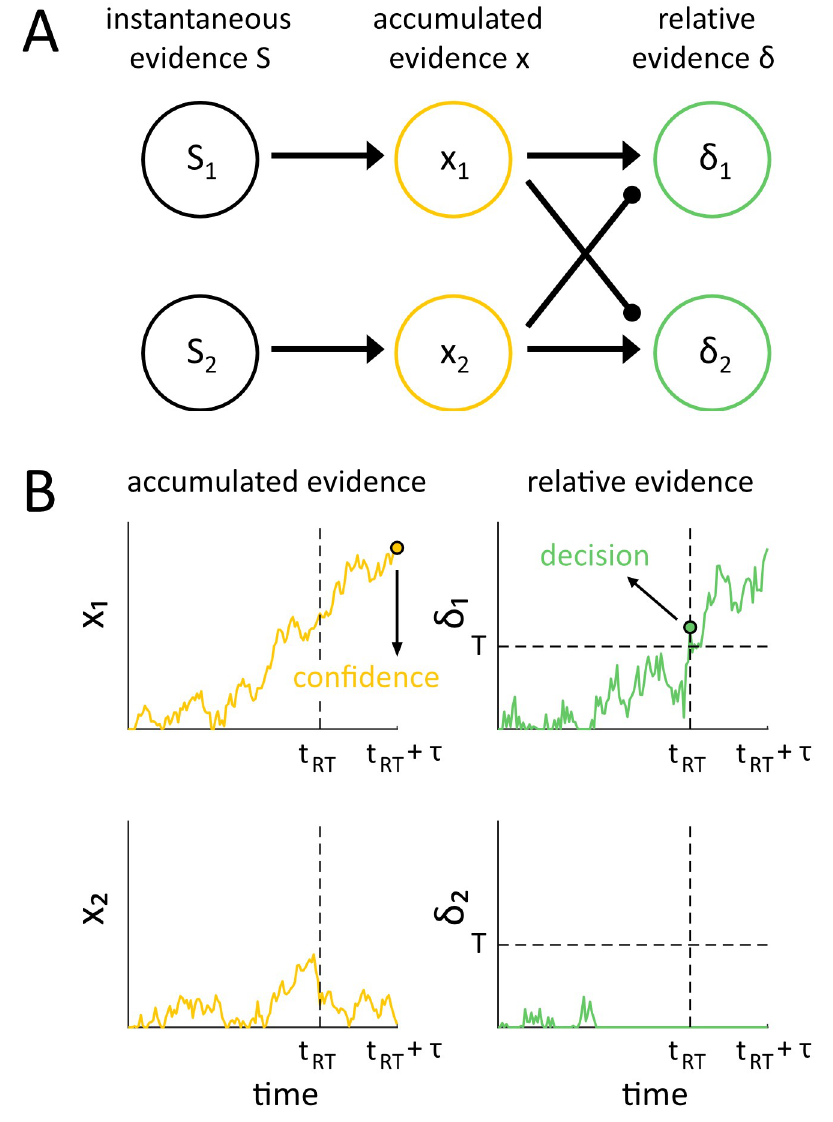
Fig 1. The Differential Tuned Inhibition model diagram and sample activity traces. (A) In the 2-stage model, instantaneous evidence from a source S i is accumulated by independent accumulators x i tuned to each stimulus type i . Differencing units δ then compute the difference in accumulated evidence for each stimulus alternative, implemented i through feed-forward excitation from units with the same preferences and inhibition from accumulator units with opposing preferences. (B) A decision is made by the model when the activity of one of the differencing units hits a bound, i.e. when enough relative evidence for one stimulus over another has been accumulated. Confidence in the main Differential Tuned Inhibition model is then read out after delay τ from the independent accumulator x D corresponding to the decision D that was made. In an alternative model, we also tested how this framework might perform if confidence were read out from the differencing unit δ D ; see Methods for